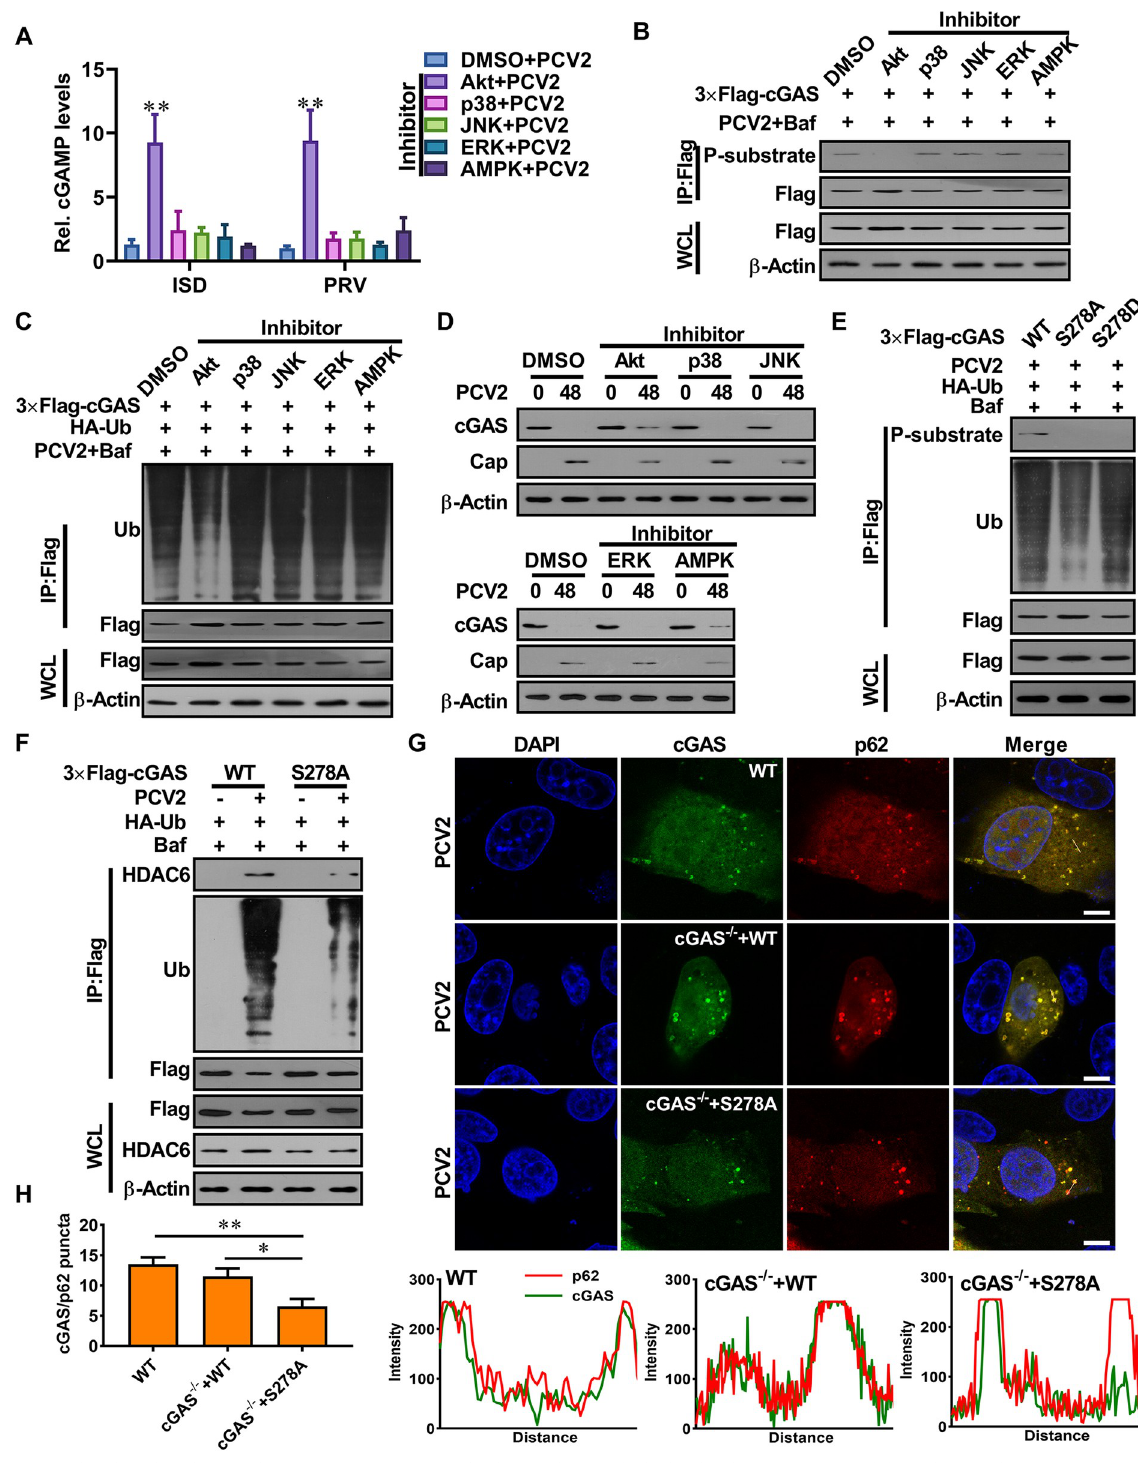
Fig 6. The phosphorylation of porcine cGAS at Ser278 facilitates the K48-linked poly-ubiquitination and degradation of porcine cGAS during PCV2 infection. (A-B) Akt signaling negatively regulates cGAS-mediated cGAMP production in the PCV2-infected cells via phosphorylation of porcine cGAS at S278. PK-15 cells pretreated with indicated inhibitors were infected with PCV2 (MOI = 5) for 12 h, and then the relative cGAMP production levels were determined at 6 h following ISD stimulation or PRV infection (A); the phosphorylation level of cGAS at the S278 site was detected by western blotting (B). � P < 0.05, �� P < 0.01 (compared with DMSO/mock infection). (C, D) The